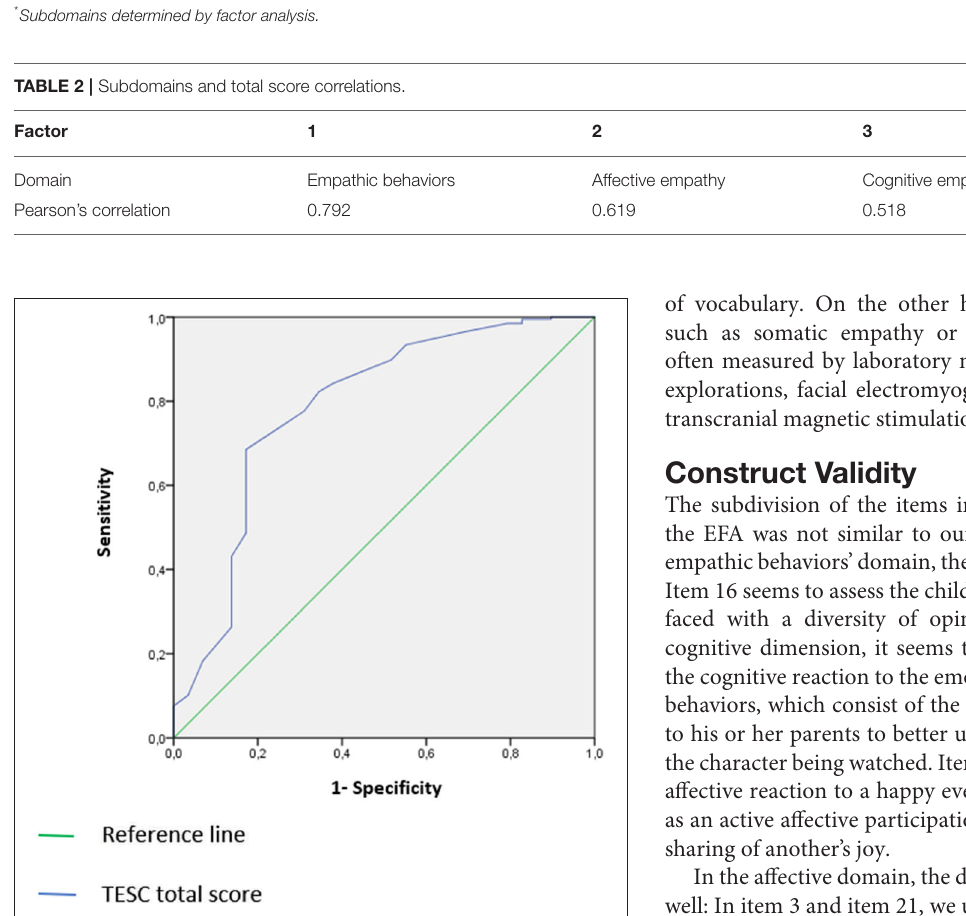
FIGURE 1 | ROC curve of the total score of the TESC with clinical and general pediatric